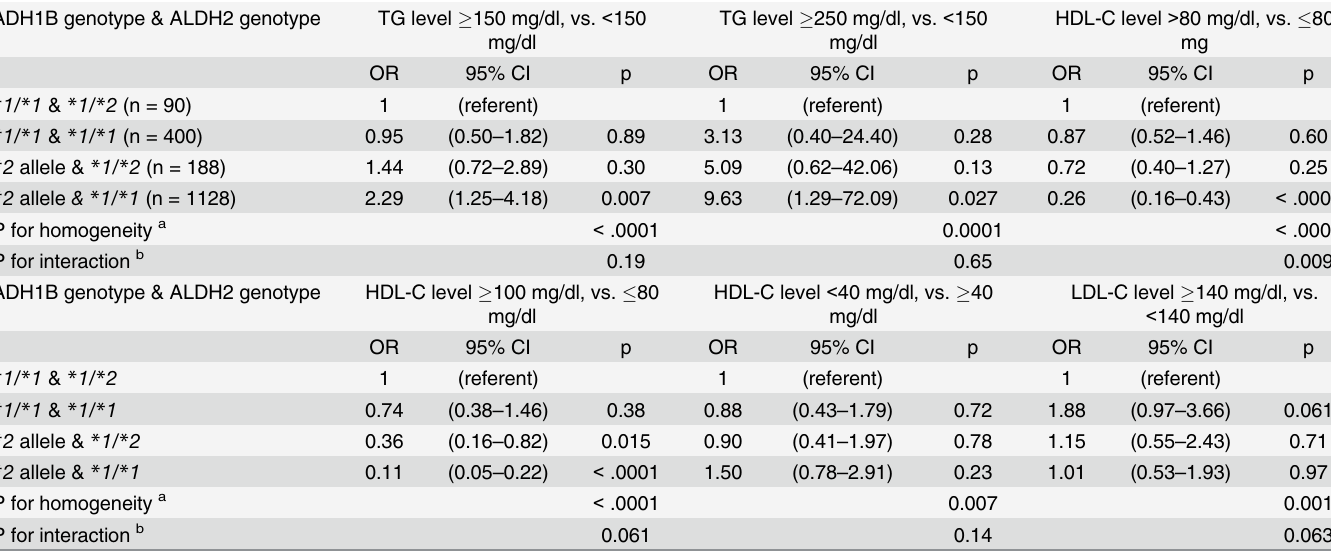
Table 5. Multiple logistic regression analysis of dyslipemia in Japanese alcoholic men according to combinations of ADH1B and ALDH2 geno- types after adjustment for other independent variables. ADH1B genotype & ALDH2